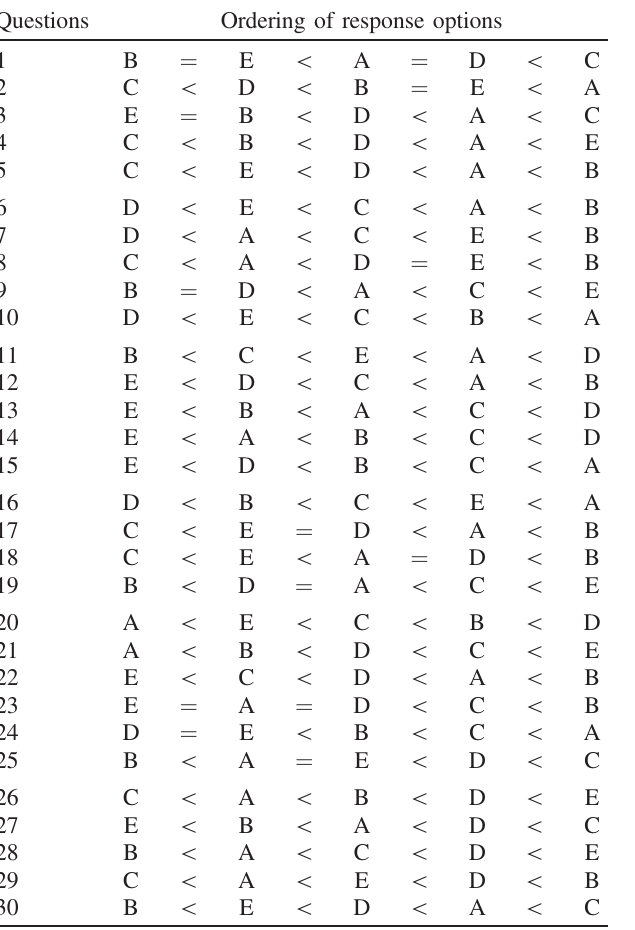
TABLE I. Ordering of response options as given by the 2PLNRM. A difference of less than 0.10 in the mean slope parameter, see Table III in the Appendix, was treated as a tie in the ordering.